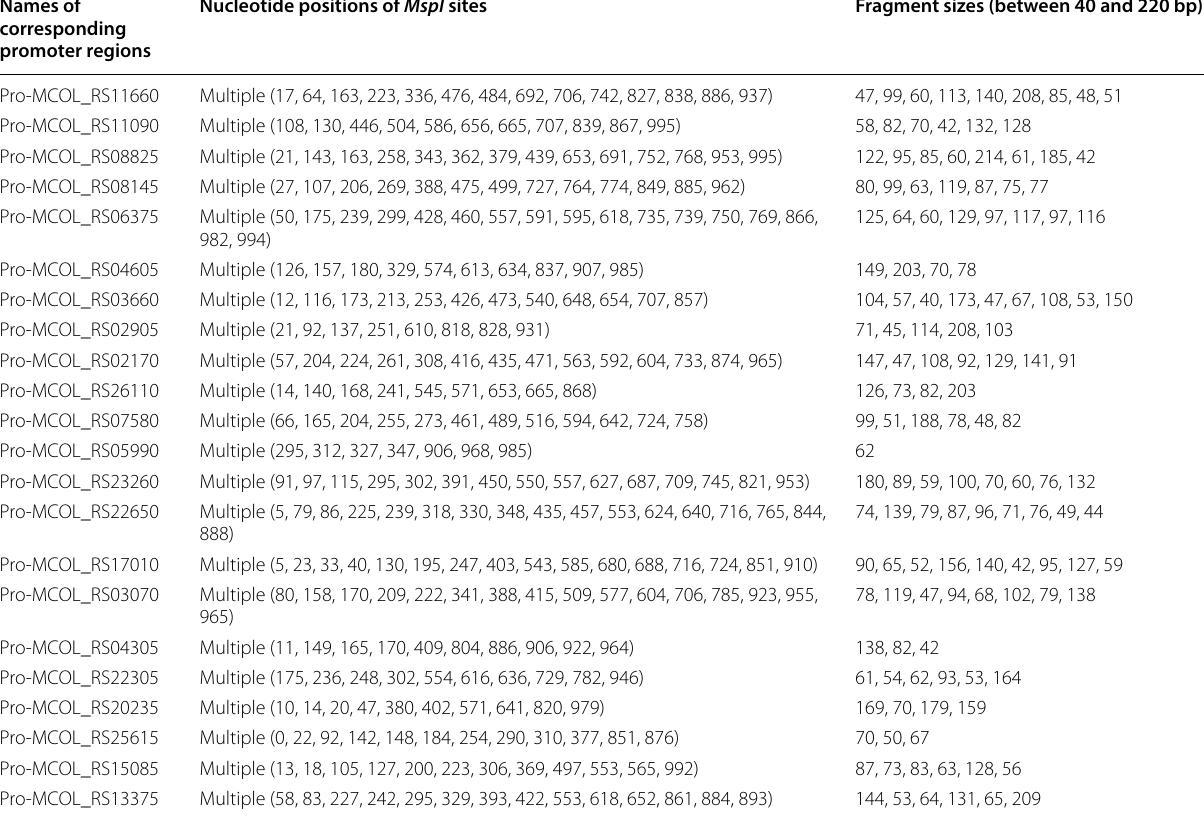
Table 4 Determination of MspI sites and fragment sizes for promoter regions Names of Nucleotide positions of MspI sites Fragment sizes (between 40 and 220 corresponding promoter regions